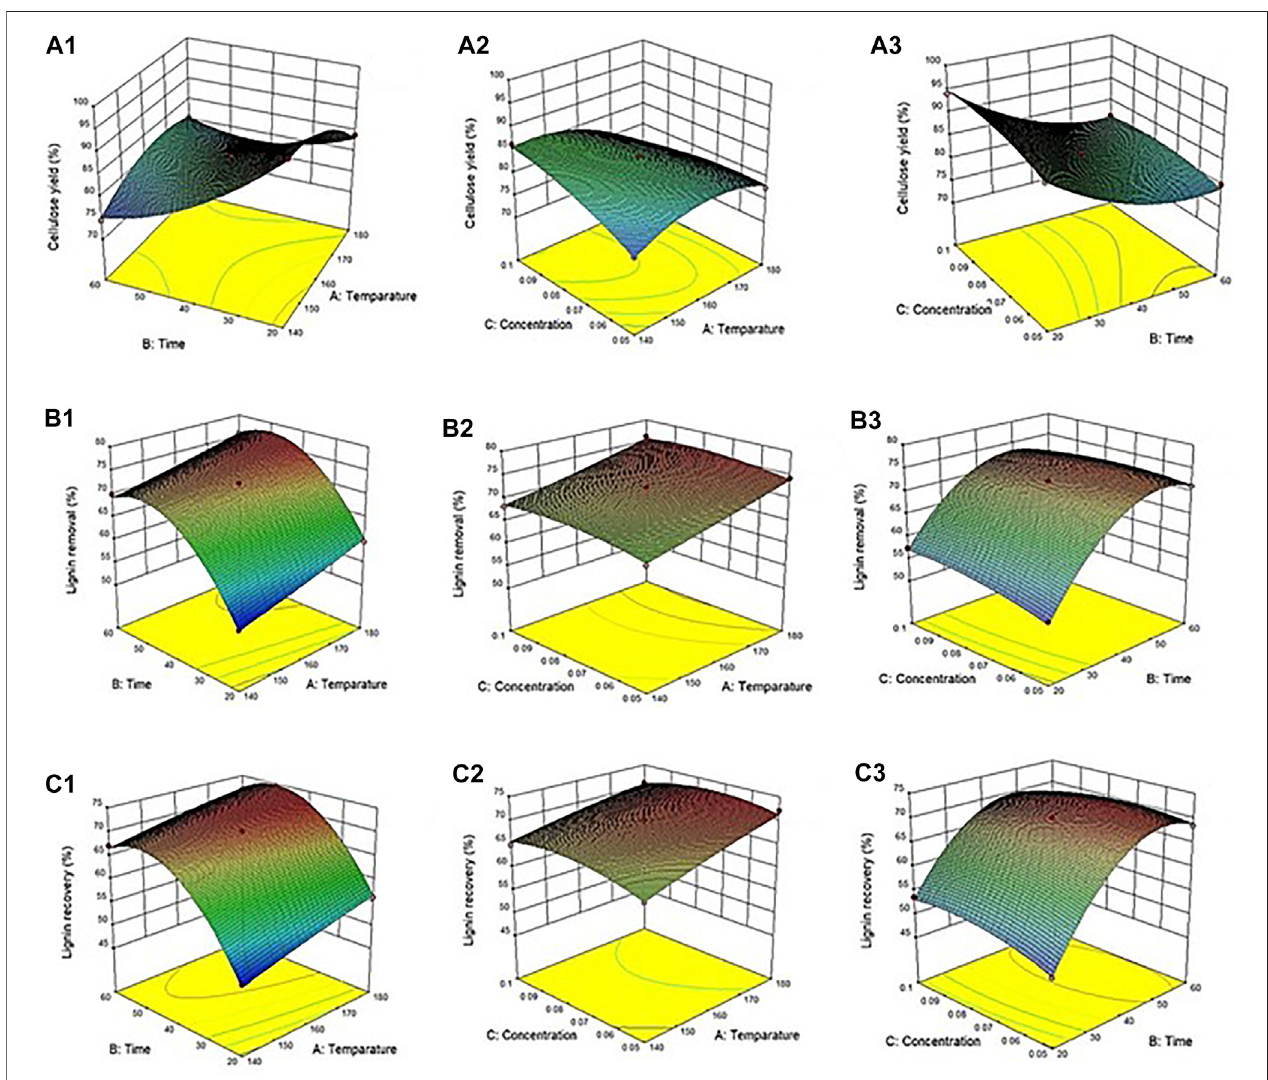
FIGURE1| Responsesurfaceplotofthesolvothermalfractionationprocess:Effectofvariousparameterson (A) celluloseyield (B) ligninremovaland (C) recovered lignin.